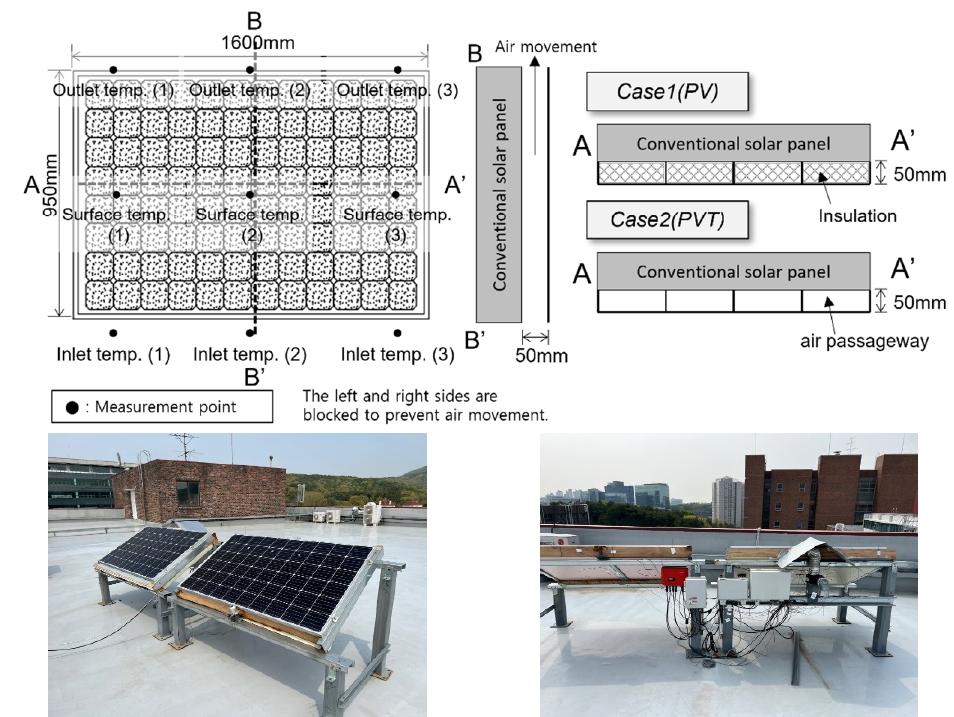
Figure 1. Schematic of experimental arrangement and experimental setup.